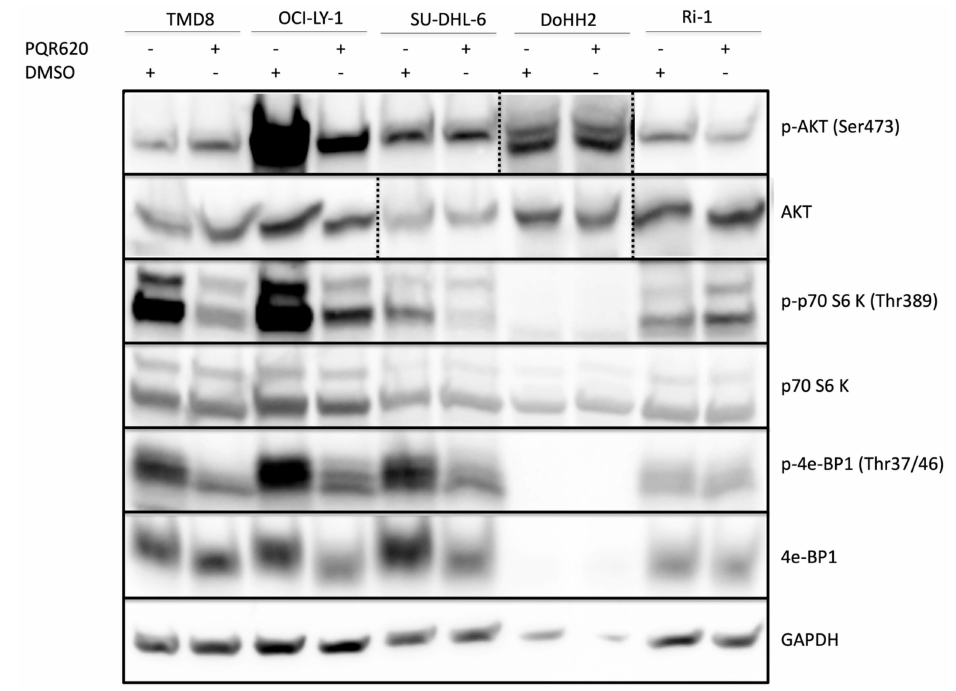
Figure 1. PQR620 a ff ects TORC1 / 2 signaling pathways by downregulating p-AKT, p-p70 S6 and p-4e-BP1 in most cell lines. Two ABC-DLBCL (TMD8, Ri-1) and three GCB-DLBCL (OCI-LY-1, SU-DHL-6, DoHH2) cell lines were treated with PQR620 (2 µ M, 24 h) or, as control,